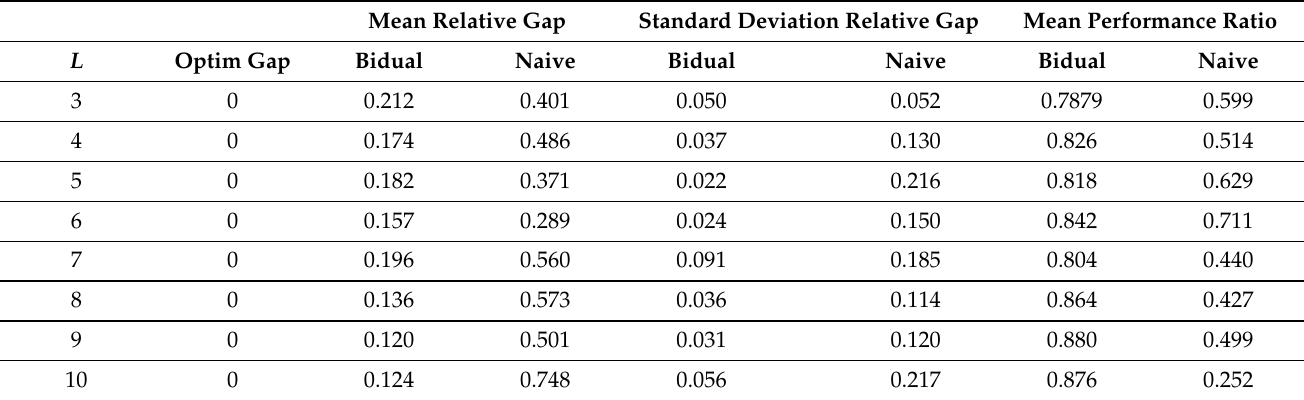
Table 1. Comparison of the proposed solution by DFW with the optimal solution by CPLEX, as well as lower bound comparisons. Mean Relative Gap Standard Deviation Relative Gap Mean Performance Ratio